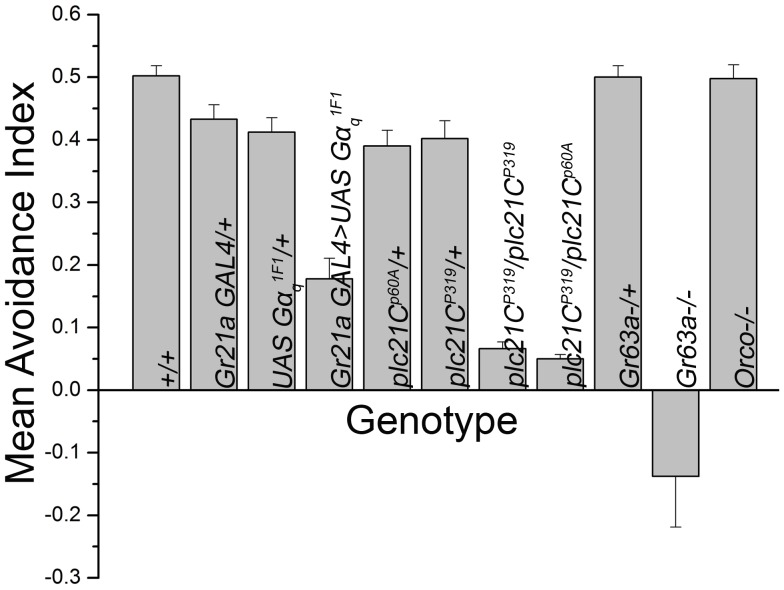
Disruption of plc21C gene leads to impaired CO2 sensing.Behavior analysis with 3 to 4 days old flies using the Y-maze with 5% CO2 and air shows reduced CO2 avoidance in flies homologous for the plc21C insertion allele plc21CP319 (plc21CP319/plc21CP319) and heterologous with plc21C deficiency mutant plc21Cp60A (plc21CP319/plc21Cp60A). Heterozygous controls show normal behavioral avoidance (p<0.0001; two tailed student’s t test). Gr63a−/− flies were used as a negative control. Error bars indicate SEM.